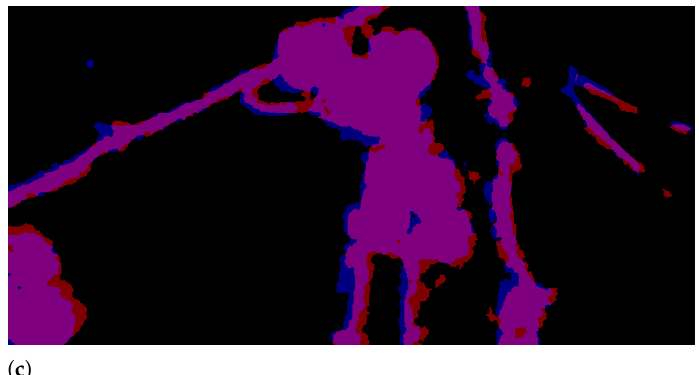
Figure 5. Two images from different locations shifted to maximize overlapping areas. The purple regions represent the overlap. ( a ) First image. ( b ) Second image. ( c ) Both images overlaid.